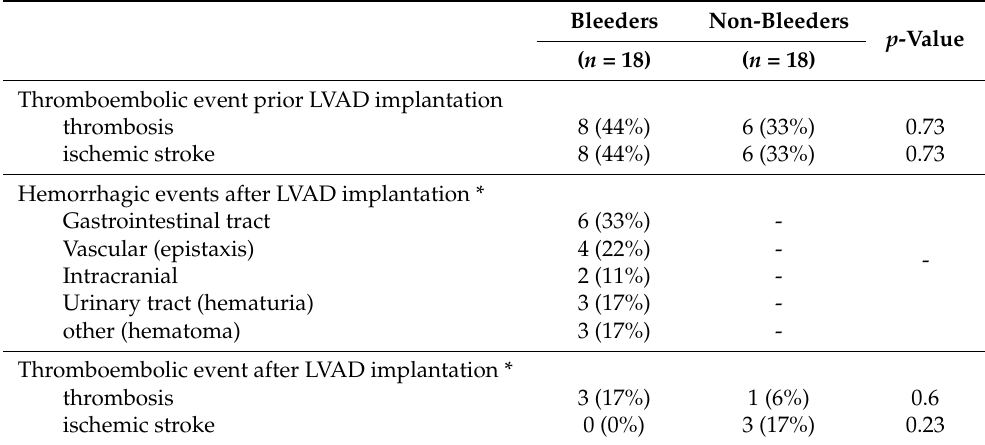
Table 2. Thromboembolic and hemorrhagic